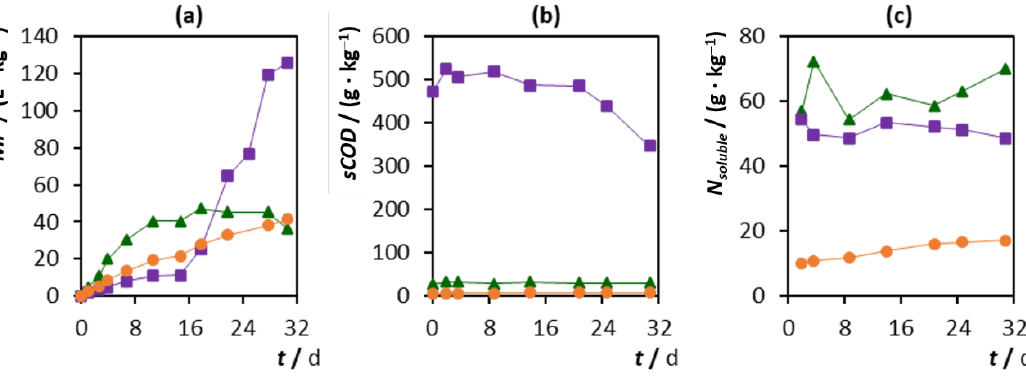
Figure 1. ( a ) Cumulative methane production (MP), ( b ) soluble COD (sCOD) and ( c ) N soluble measured over the degassing process of the digested sewage sludge (DSS, ▲ ), granular sludge (GS, ⚫ ) and fresh dairy manure (DM, ◼ ). All parameters are expressed per kg of VS of inoculum added in the beginning of the assay.